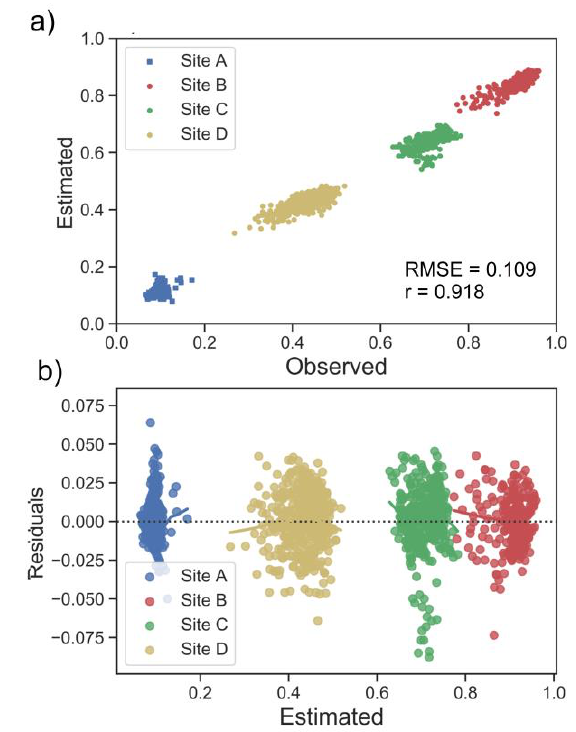
Figure 4. Correlation analysis between the actual and synthetic Sentinel-2 NDVI on May 09, 2017 in four sites over the study